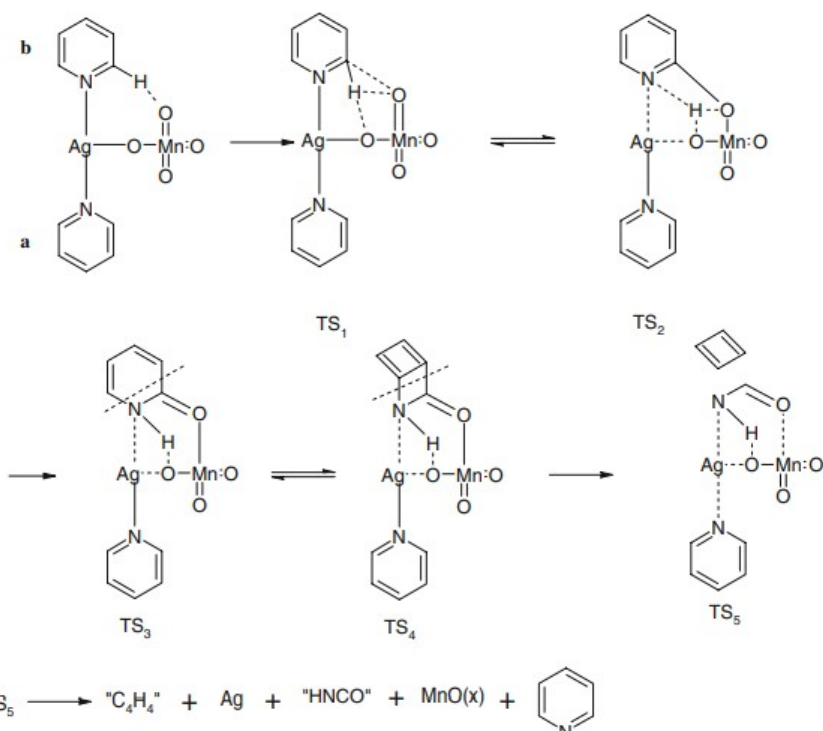
Figure 4. Proposed mechanism for the thermal decomposition of AgPy 2 MnO 4 [16]. a -non-hydrogen bound pyridine ring: b-hydrogen bound pyridine ring.